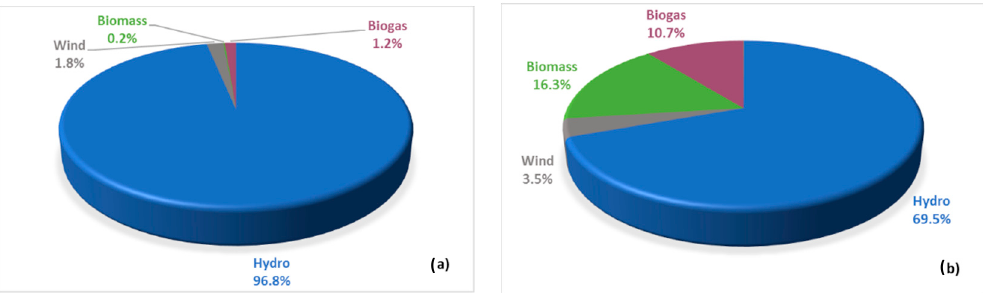
Figure 3. The distribution of electricity generation from different renewable energy sources in Latvia: ( a ) 2008 and ( b ) 2018 [31].